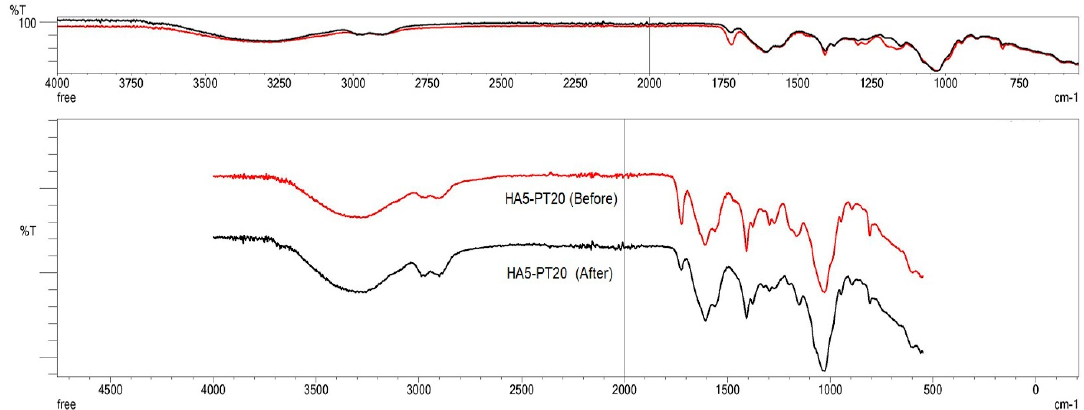
Figure 13. HA5-PT crosslinked by oven-assisted thermal method (x-axis is the wavenumber/cm − 1 ).